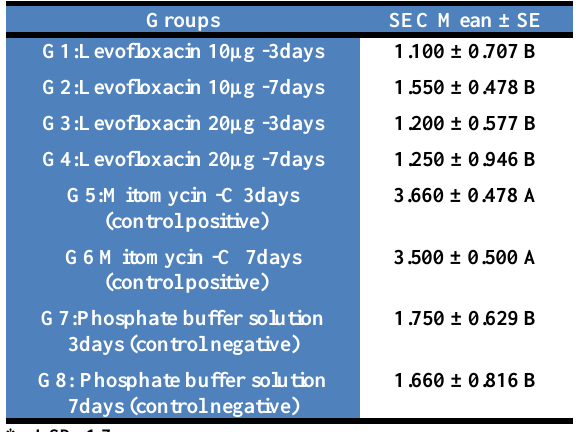
Table, 3: Sister chromatid exchange of chick embryo cells in two different stages of incubation (3 and 7 days) exposed to two different concentrations of levofloxacin.